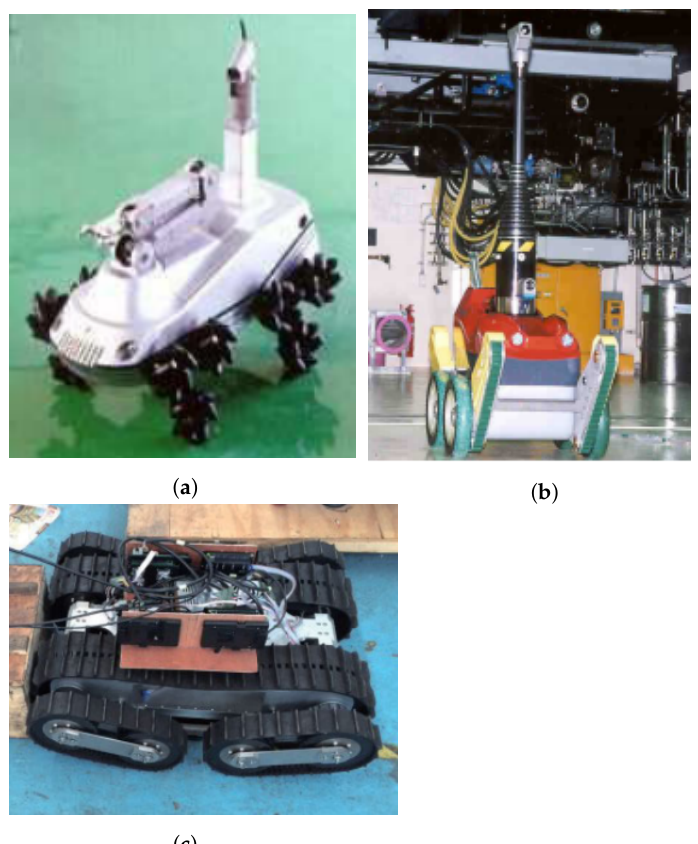
Figure 1. Examples of unmanned ground vehicles (UGVs) types: ( a ) UGV with wheels and a manipulator. ©2010 IEEE. Reprinted, with permission, from Reference [47]. ( b ) UGV with wheels and four tracks. ©2010 IEEE. Reprinted, with permission, from Reference [47]. ( c ) UGV with tracks. ©2014 IEEE. Reprinted, with permission, from Reference